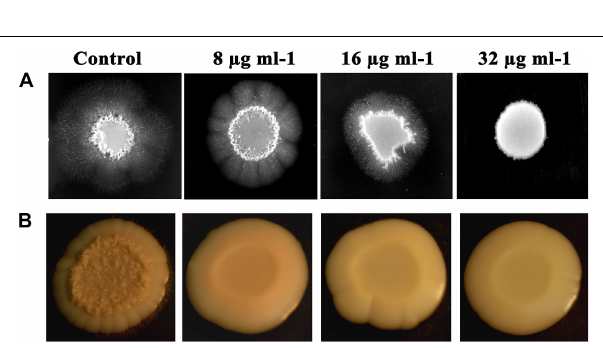
FIGURE 4 | Piperine impeding the primary virulence attributes of C. albicans. (A) Filamentous development of C. albicans under the impact of piperine. (B) Wrinkle colony